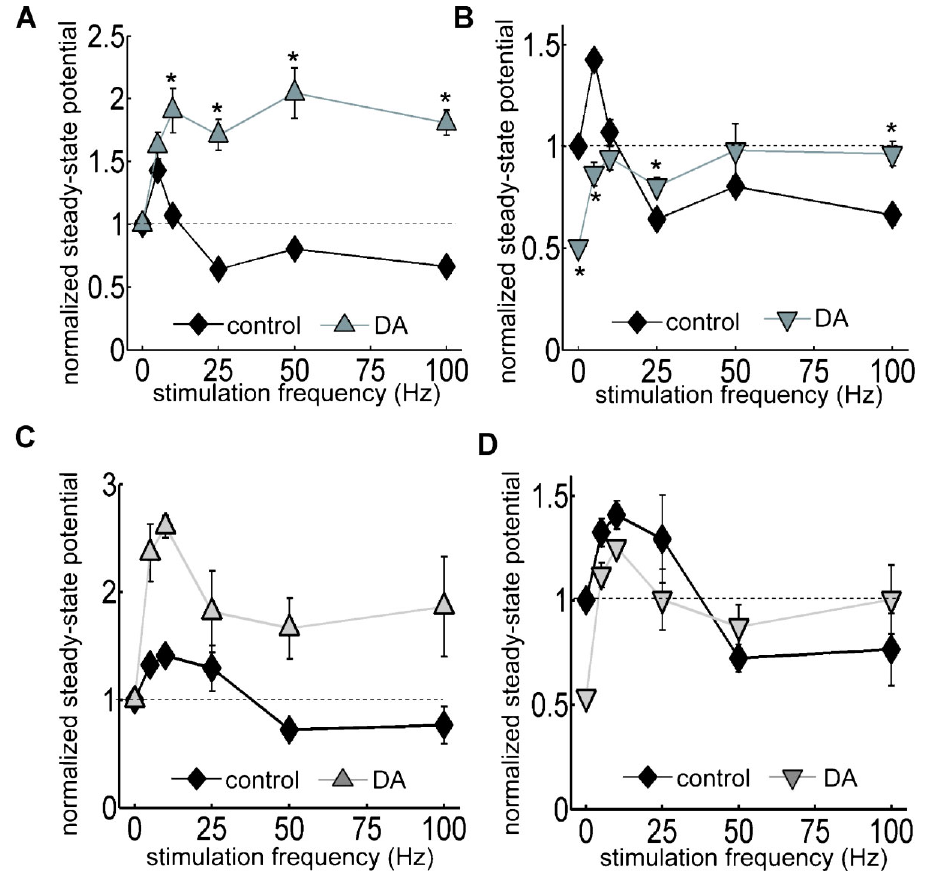
Figure 6. Analysis of DA-induced filtering at TA-CA1 synapses at room and near physiological temperatures . ( A ) Using same data as in Figure 5 , steady-state potentials were measured. In the presence of DA, the steady-state potential became larger during HFS. p<0.05 relative to control (from left to right; control: n = 5, 5, 7, 6, and 5, DA: n = 5, 5, 5, 5, and 5). ( B ) As in Figure 5B , data were normalized to baseline fEPSP amplitude prior to DA application. Thus, this figure shows the total effect of DA, including on the depression of basal synaptic transmission. Under DA application, although the steady-state potential was smaller during low-frequency stimulation, it overcame the depression and became larger than control during HFS. p<0.05 relative to control. Note that control error bars are smaller than the symbol size. ( C ) Similar experiments as A conducted at higher temperature (32–34 ◦ C). (D) Similar analysis as B , using data acquired at higher